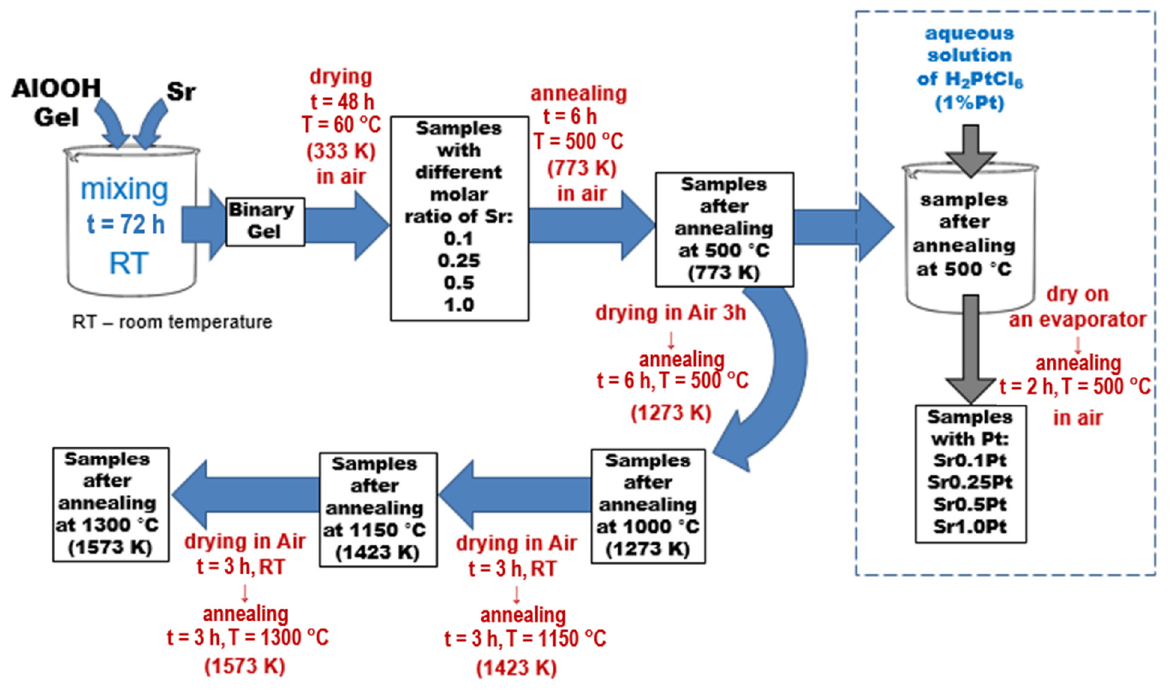
Figure 8. Schematic procedure of Al 2 O 3 /SrCO 3 xerogels synthesis.